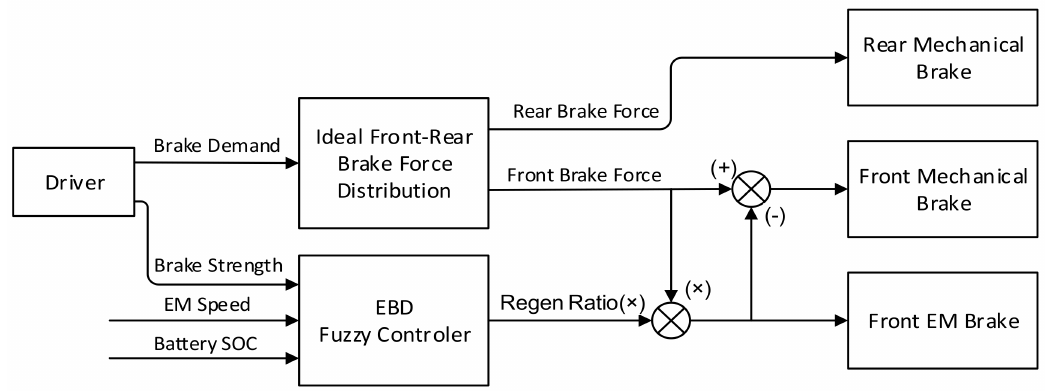
Figure 12. Simplified block diagram of the racing mode control strategy. Note, SOC: state of